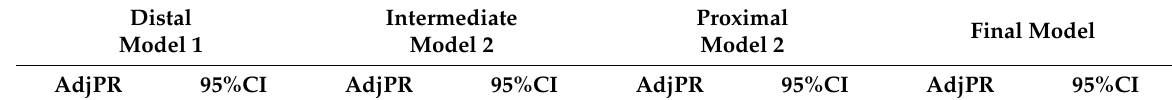
Table 3. Factors associated with overweight in adults from Rio Branco, Acre,